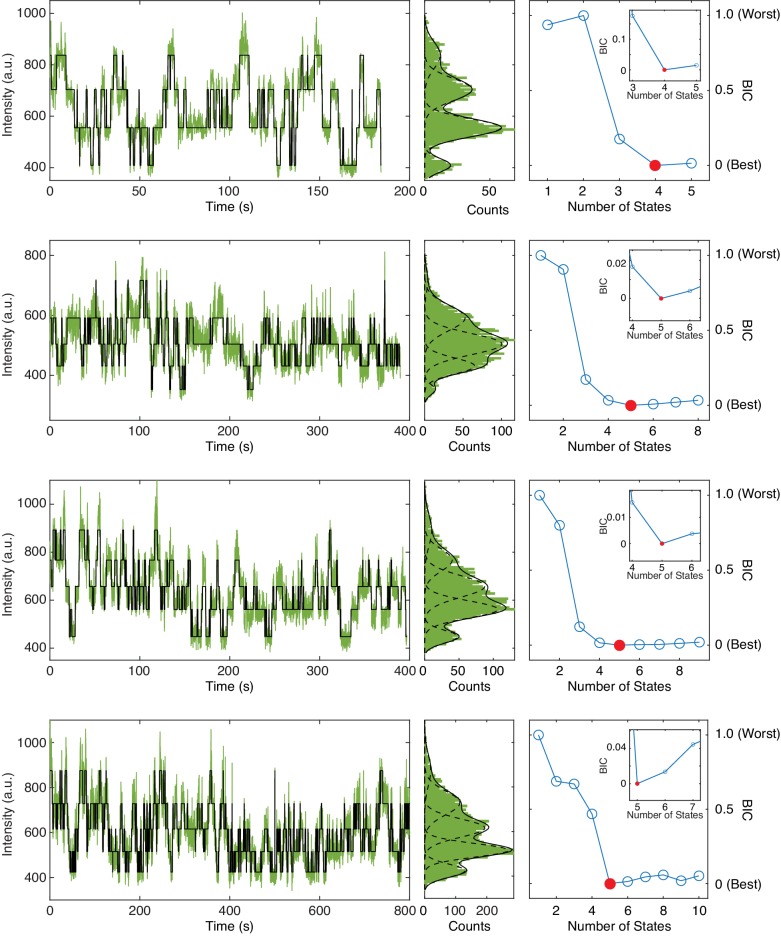
Example trajectories of 1 µM fcAMP binding to tetrameric CNBDs in ZMWs.Representative trajectories featuring up to 3 or four bound fcAMP molecules analyzed by DISC (left) with distribution fits (middle) and BIC curves for optimal state selection (right). Inset shows a zoomed portion of BIC curve to highlight the minimum BIC value identified. The lowest BIC value is indicated in red which corresponds to the final number of states fit to the trajectory. Each BIC plot may feature a different number of total possible states owning to the trajectory-by-trajectory results from divisive segmentation.